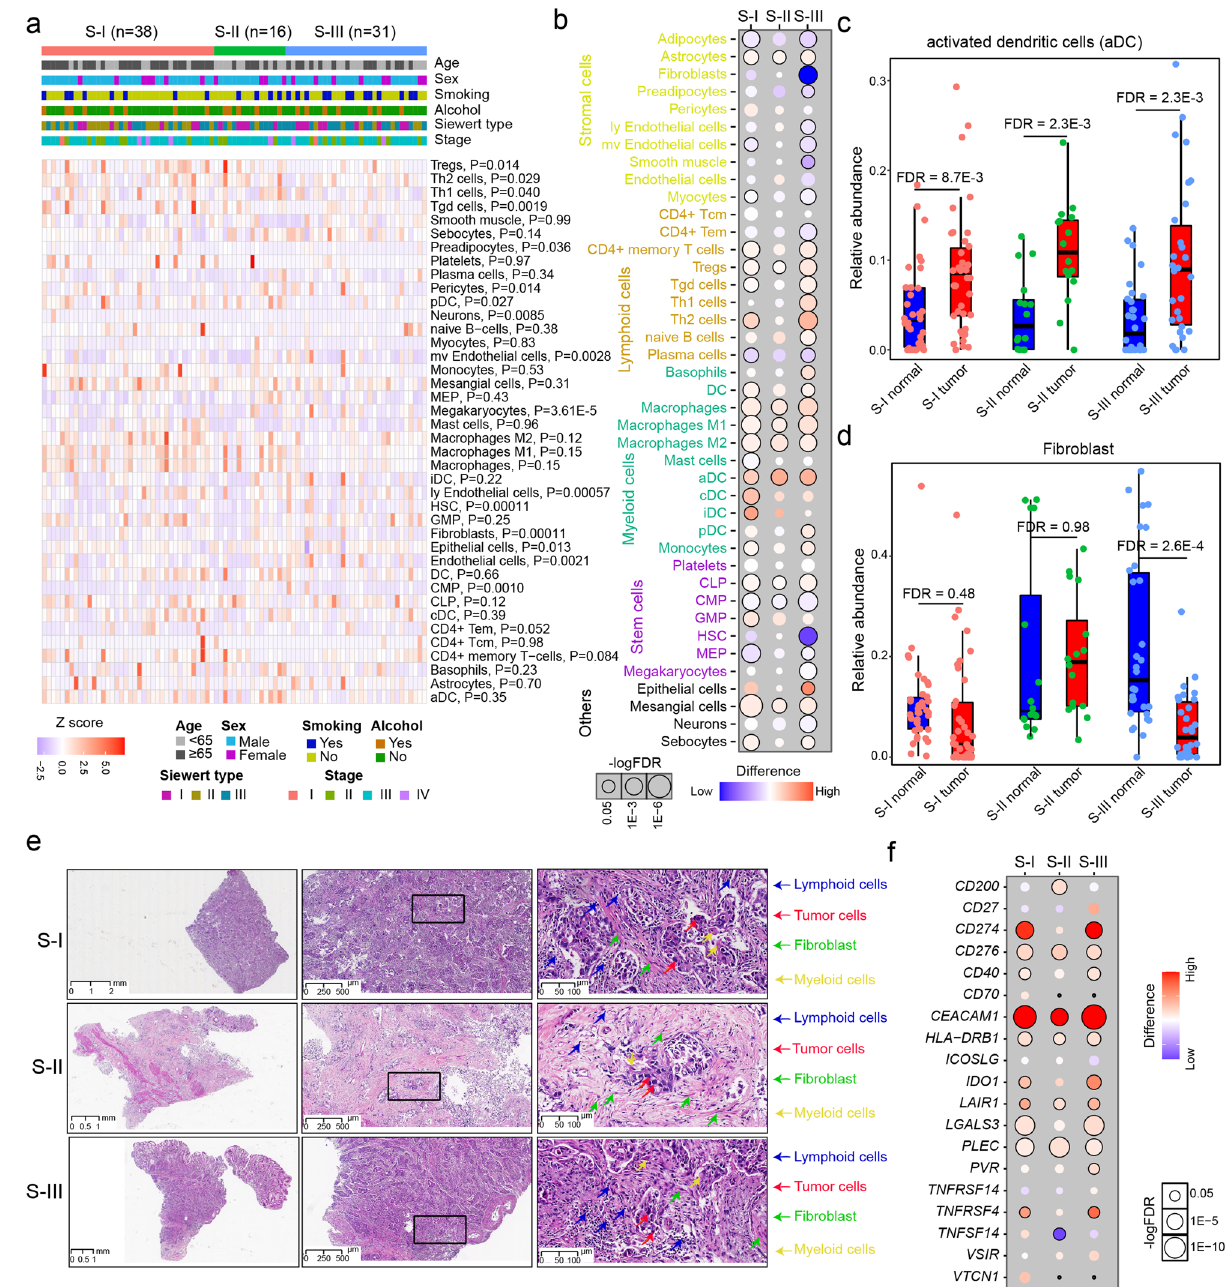
Fig. 6 | Immune in fi ltration across different proteomic subtypes. a Heatmap showing the relative abundance of different cells across samples of the three AEG subtypes. The Kruskal – Wallis Rank Sum test was used to compare the differences between subtypes. P , Kruskal – Wallisrank sum test. b The difference in the relative abundanceofdifferentin fi ltratingcellsinthethreeAEGsubtypes.FDR,Wilcoxon ’ s rank-sum test. c Comparisons of aDC abundance between AEG tumor and NAT samples in the S-I, S-II, and S-III subtypes ( n =40 for S-I, n =23 for S-II, n =40 for S-III). FDR, Wilcoxon ’ s rank-sum test. d Comparisons of fi broblast abundance